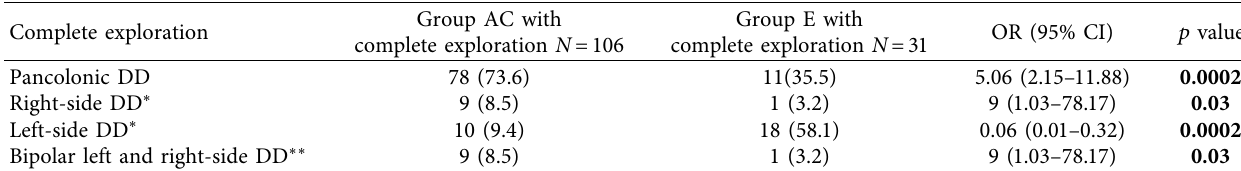
Table 2: Complete exploration of the colon in African Caribbean and European patients.